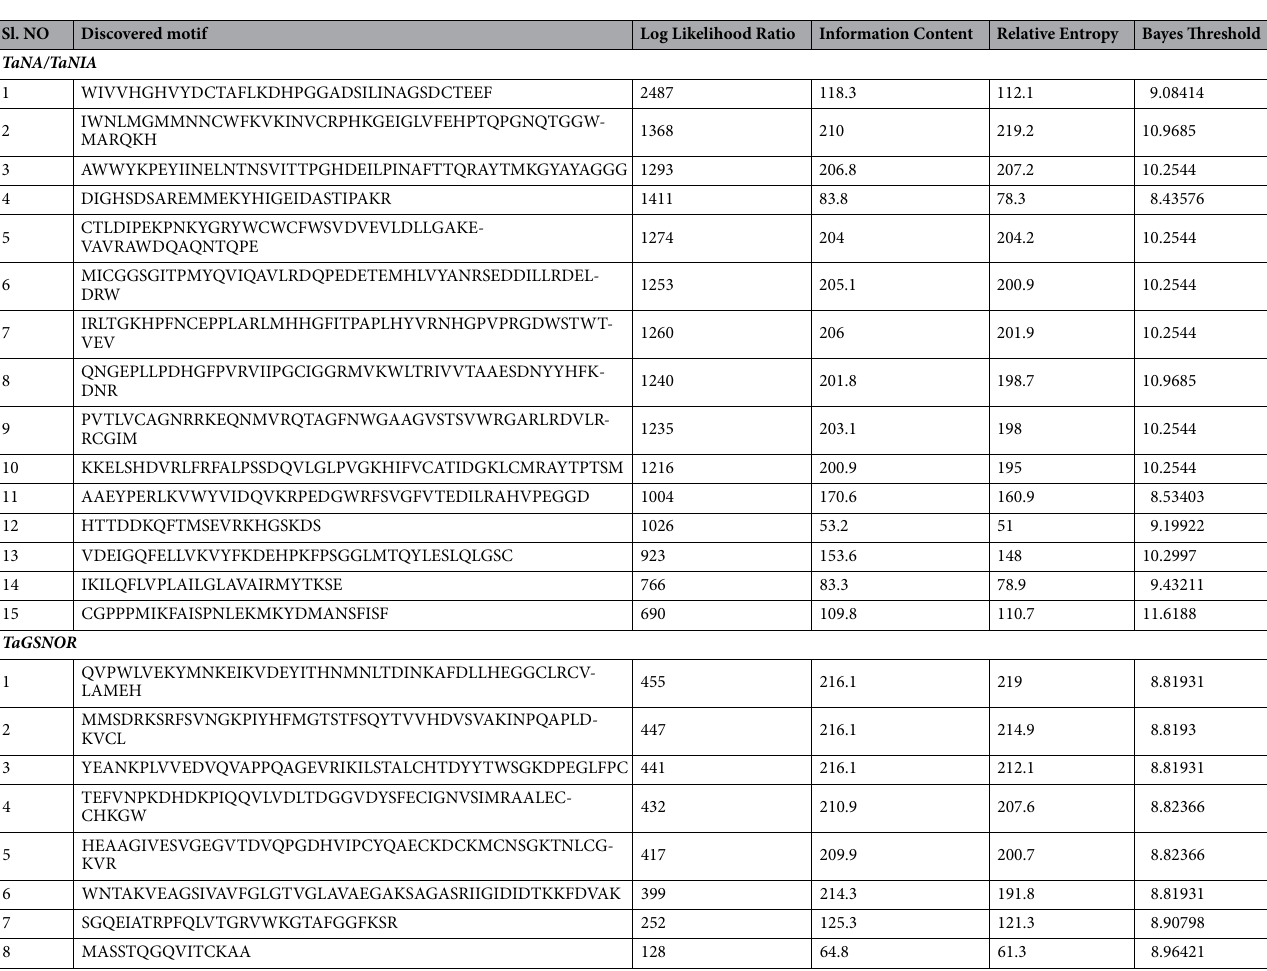
Table 4. Details of discovered motif in identified TaNIA and TaGSNOR